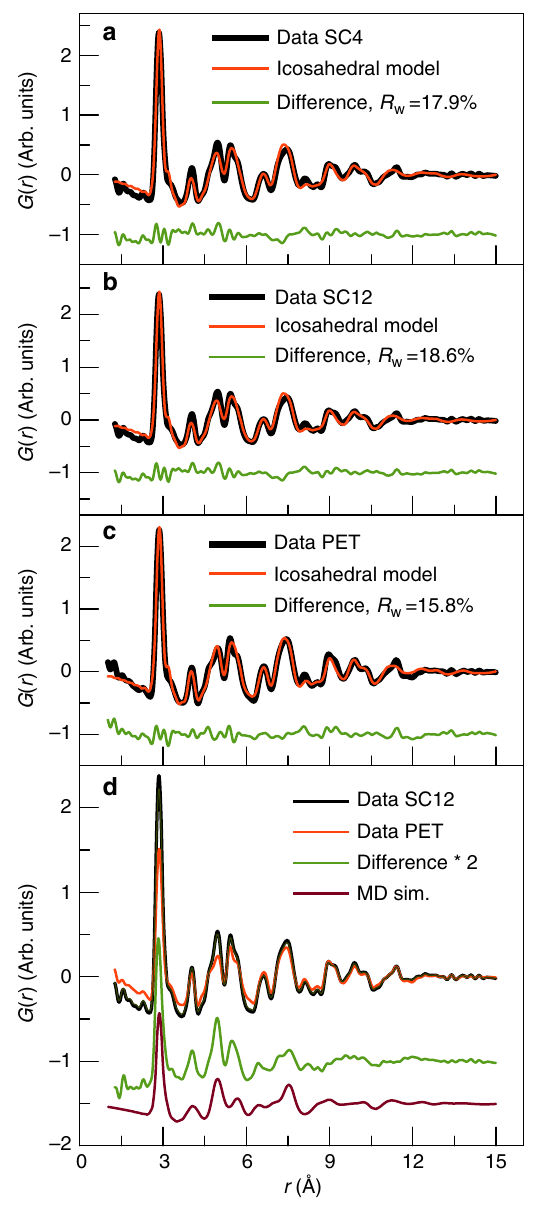
Figure 5 | Fits of the Bahena model to experimental data. ( a ) Fit to Au 144 (SC4) 60 data, ( b ) to Au 144 (SC12) 60 data and ( c ) to Au 144 (PET) 60 data. ( d ) Data for the Au 144 (PET) 60 and Au 144 (SC12) 60 ; the difference between them and the calculated PDF from the 114-atom decahedron model. The difference curve has been doubled in scale for